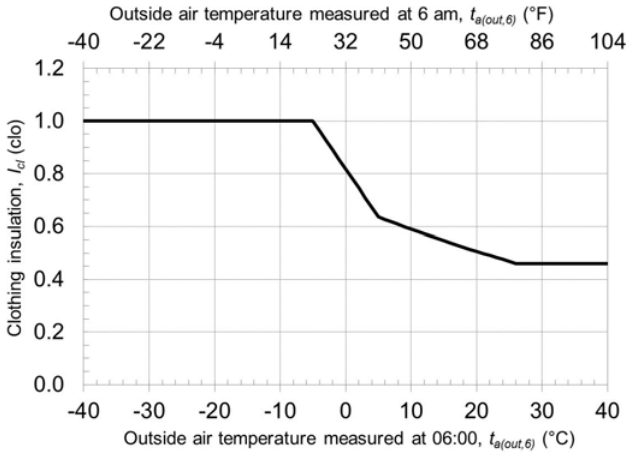
Figure 1. Graphical representation of the proposed model for thermal comfort standard described in Equation